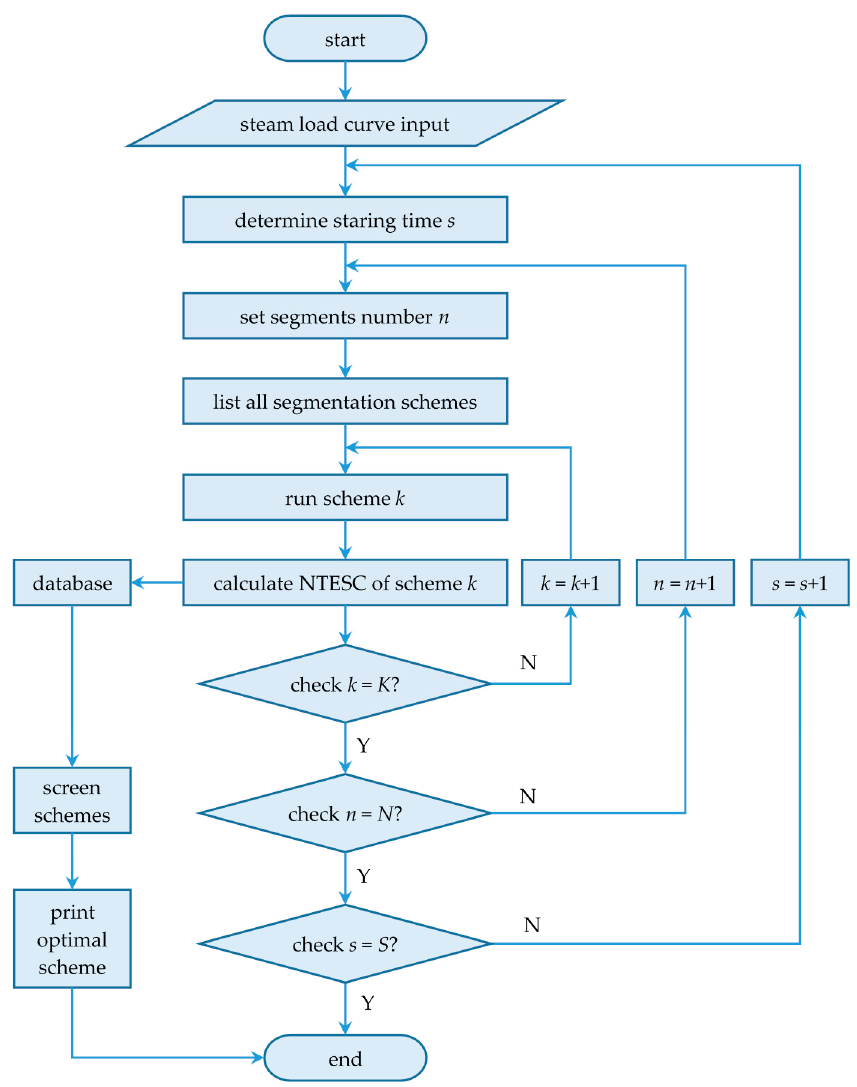
Figure 7. Problem solving flow chart. NTESC: necessary thermal energy storage capacity.